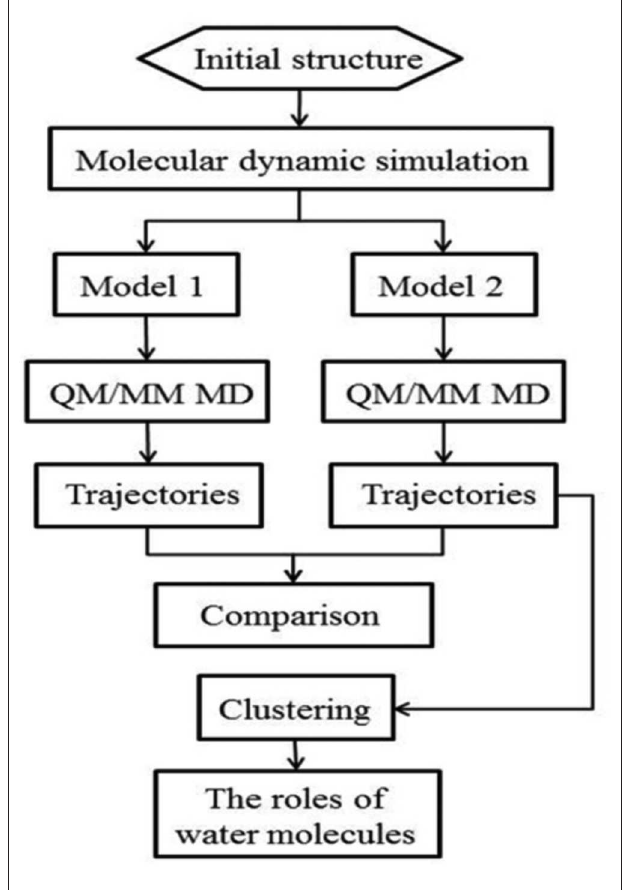
FIGURE 2 | Schematic illustration of the workflow of the system setup and the QM/MM MD